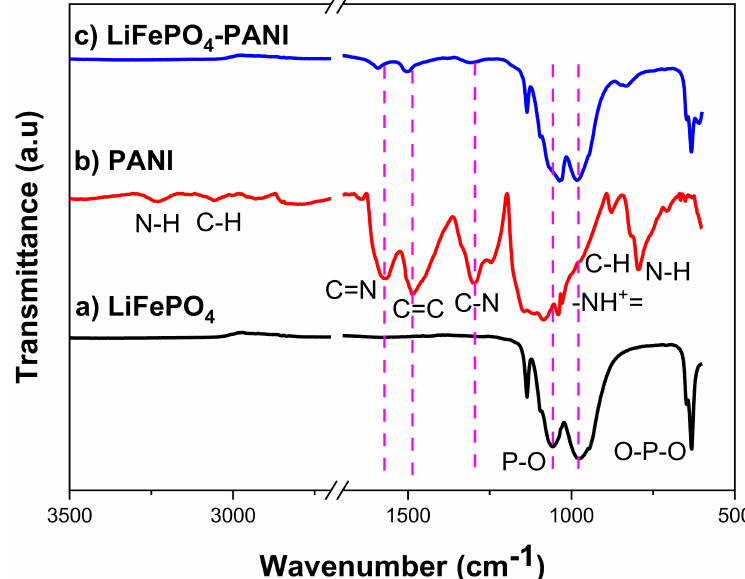
Figure 10. FTIR spectra for: ( a ) LiFePO 4 , ( b ) PANI and ( c ) LiFePO 4 –PANI.